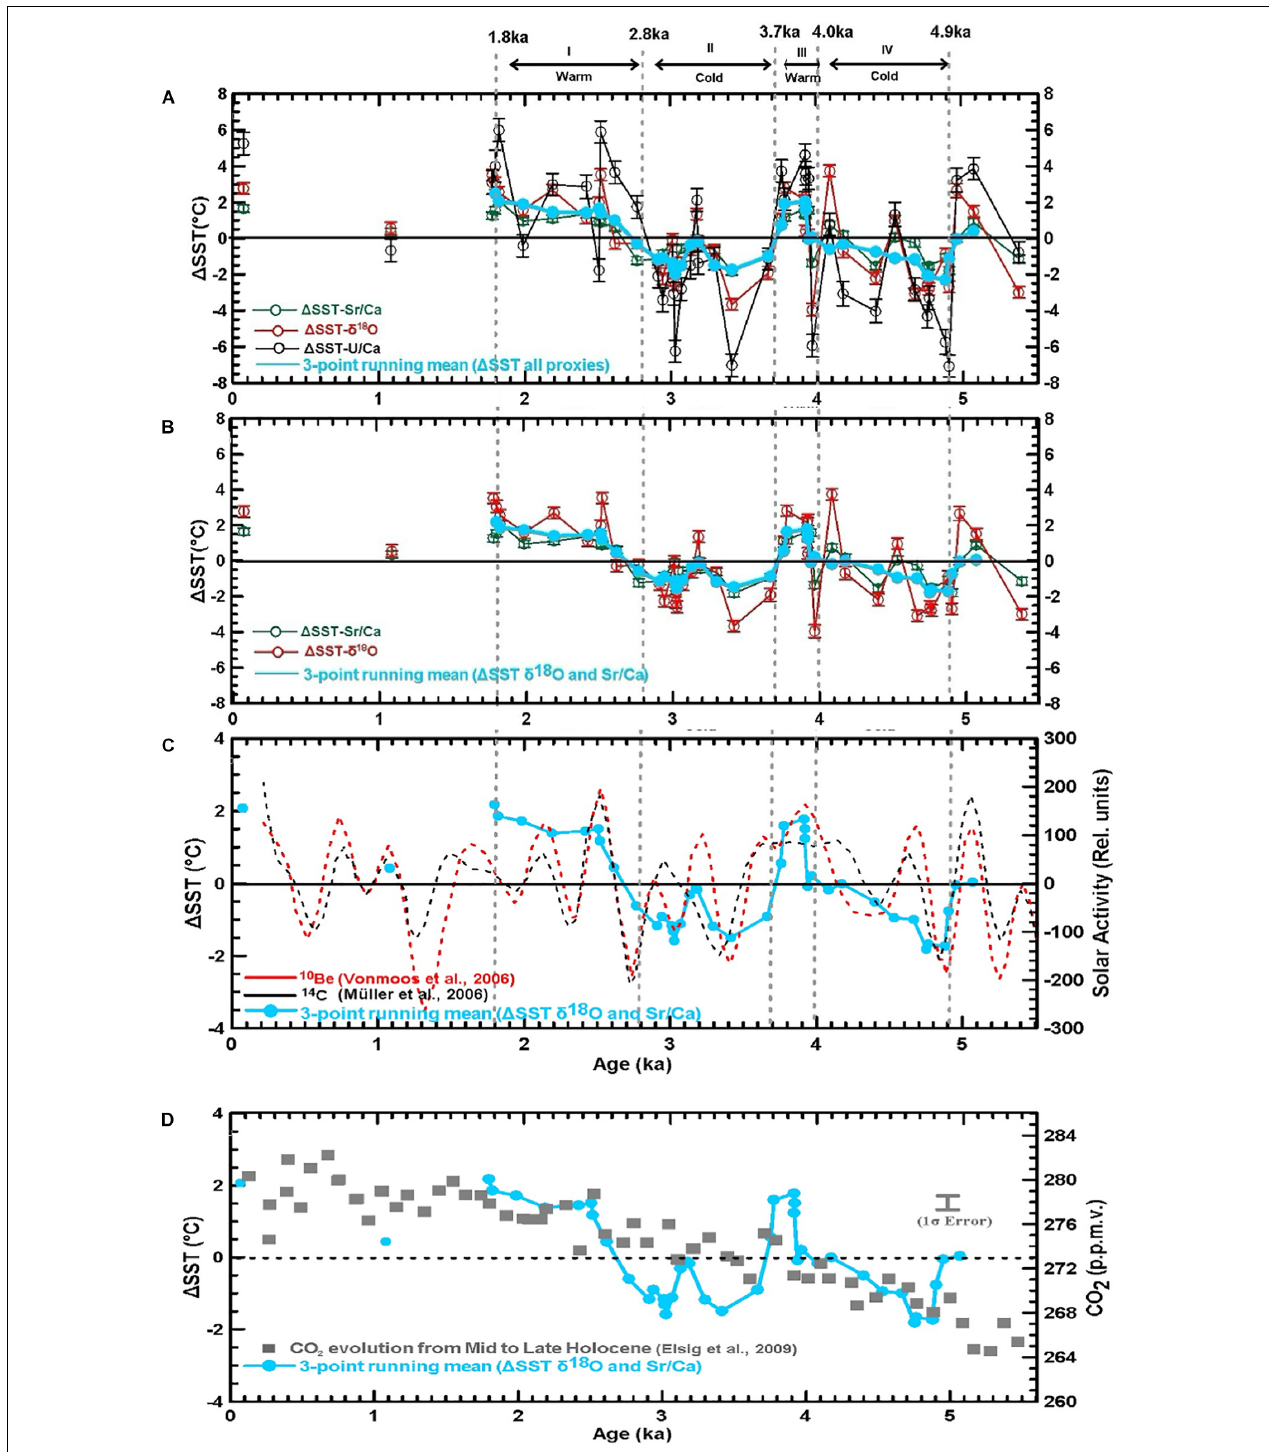
FIGURE 9 | (A) Reconstructed (cid:49) SSTs from Sr/Ca, δ 18 O, and U/Ca series plotted against age, including a mean weighted average of all (cid:49) SST proxies (blue curve). Four intervals of alternating SSTs can be identified: two warm periods (where the SST is above the mean, intervals I and III) and cold intervals where the SST is below the mean (intervals II and IV); (B) reconstructed (cid:49) SSTs from Sr/Ca and δ 18 O only; (C) comparison of mean weighted average (cid:49) SST estimates (blue line, 3-point running mean from δ 18 O and Sr/Ca) with solar activity reconstructed using 10 Be from the Greenland (GRIP) ice core record (Vonmoos et al., 2006; dashed red line) and 14 C (Müller et al., 2006; dashed black line) from Wanner et al. (2008); (D) comparison of our mean weighted average (cid:49) SST estimates with the CO 2 concentration from Mid to Late Holocene collected from the Antarctic ice core record (Monnin et al., 2001; gray symbols) obtained from Elsig et al. (2009).